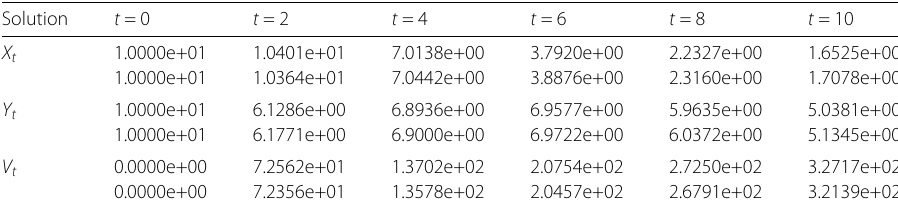
Table 3 Approximate solutions using RK4 (first row) and numerical technique (59) (second row, Ω = 0.99) with step-size h = 10 –3 over [0,10] for X (0) = 10, Y (0) = 10, V (0) = 0 having parameters k = 5, p =